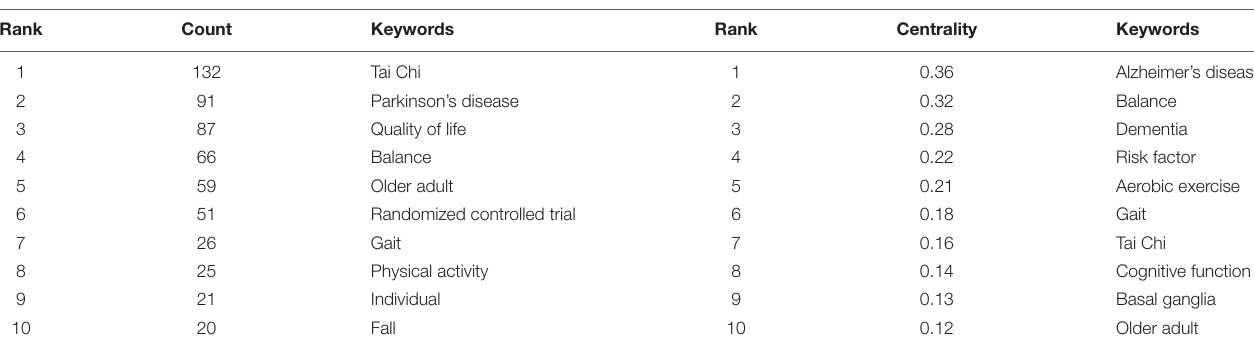
FIGURE 5 | Co-occurring keywords map. The nodes in the map represent keywords. The lines between the nodes represent co-occurrence relationships. The purple ring represents centrality. TABLE 7 | The top 10 keywords in terms of frequency and